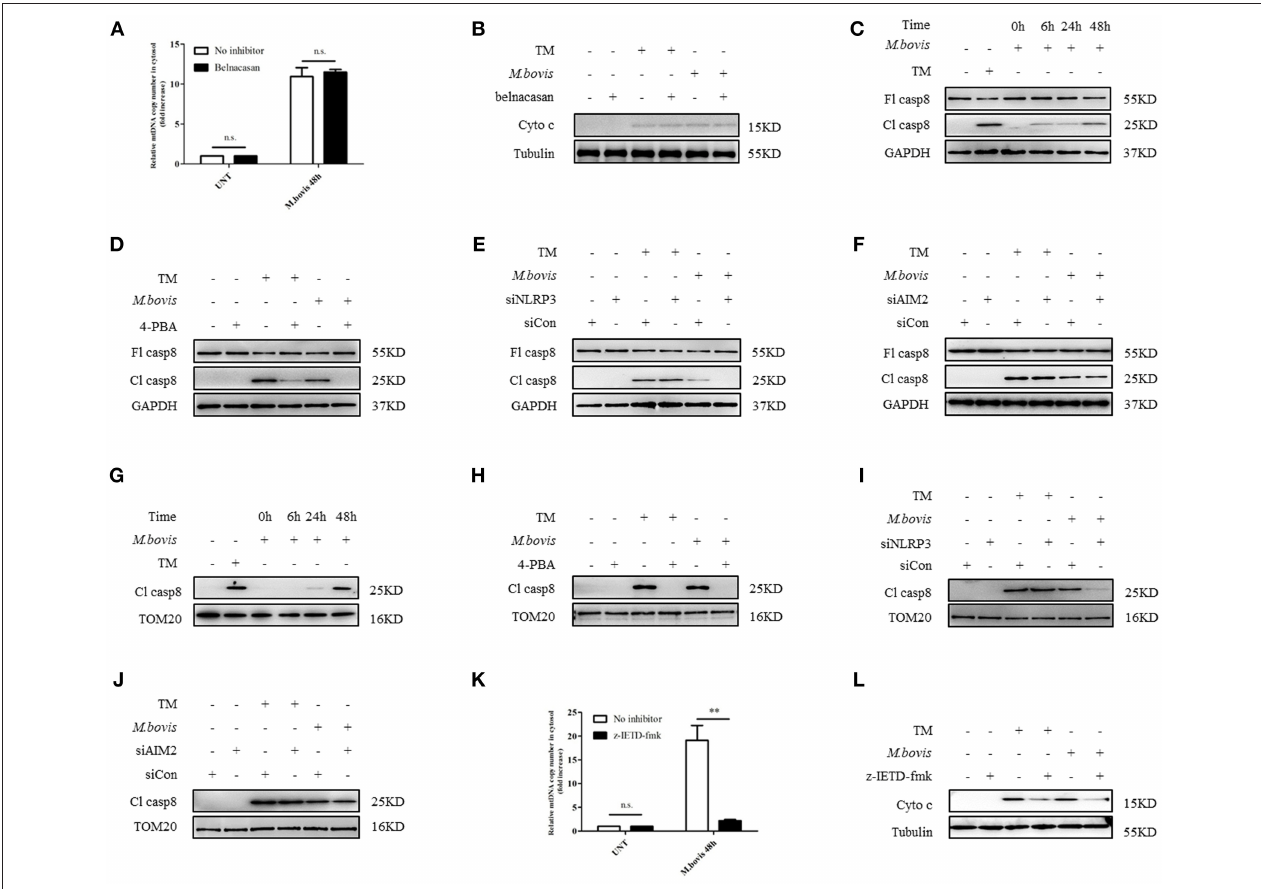
FIGURE 4 | NLRP3 and caspase-8 are required for ERS-induced mitochondrial damage. (A) qPCR analysis of mtDNA release into the cytosol in BMDMs treated with no inhibitor and belnacasan for 1h and then infected with M. bovis (MOI 10) for 48h. (B) Immunoblot analysis of cytochrome c in the cytosolic extracts from BMDMs treated with no inhibitor or belnacasan for 1h and then infected with M. bovis (MOI 10) for 48h. (C) Immunoblot analysis at different time points of caspase-8 in lysates of BMDMs infected with M. bovis (MOI 10). (D) Immunoblot analysis of caspase-8 in lysates of BMDMs treated with no inhibitor or 4-PBA for 1h and then infected with M. bovis (MOI 10) for 48h. (E) Immunoblot analysis of caspase-8 in lysates of BMDMs transfected with control non-targeting siRNA (siCon) or NLRP3 targeting siRNA (siNLRP3) and then infected for 48h with M. bovis (MOI 10). (F) Immunoblot analysis of caspase-8 in lysates of BMDMs transfected with siCon or siAIM2 and then infected for 48h with M. bovis (MOI 10). (G) Immunoblot analysis at different time points of cleaved caspase-8 in the mitochondrial fraction of BMDMs infected with M. bovis (MOI 10). (H) Immunoblot analysis of caspase-8 in the mitochondrial fraction of BMDMs infected with M. bovis (MOI 10) for 48h in the presence or absence of 4-PBA. (I) Immunoblot analysis of caspase-8 in the mitochondrial fraction of BMDMs transfected with control non-targeting siRNA (siCon) or NLRP3 (siNLRP3) targeting siRNA and then infected for 48h with M. bovis (MOI 10). (J) Immunoblot analysis of caspase-8 in the mitochondrial fraction of BMDMs transfected with control non-targeting siRNA (siCon) or AIM2 targeting siRNA (siAIM2) and then infected for 48h with M. bovis (MOI 10). (K) qPCR analysis of mtDNA release into the cytosol in BMDMs treated with no inhibitor or z-IETD-fmk for 1h and then infected with M. bovis (MOI 10) for 48h. (L) Immunoblot analysis of cytochrome c in cytosolic extracts from BMDMs infected with M. bovis (MOI 10) in the absence or presence of z-IETD-fmk. UNT, untreated; belnacasan, inhibitor of caspase-1, 20 µ M; TM, tunicamycin, positive control for ERS-induced caspase-8 cleavage, 10 µ g/mL; 4-PBA, 4-phenyl butyric acid, ERS inhibitor, 5mM; z-IETD-fmk, caspase-8 inhibitor, 50 µ M; Fl casp8, full-length caspase-8; Cl casp8, cleaved caspase-8; siNLRP3, silencing RNA for NLRP3, 50nM; siAIM2, silencing RNA for AIM2, 50nM; siCon, non-targeting control siRNA, 50nM. MOI, multiplicity of infection. The data are representative of at least three independent experiments, each